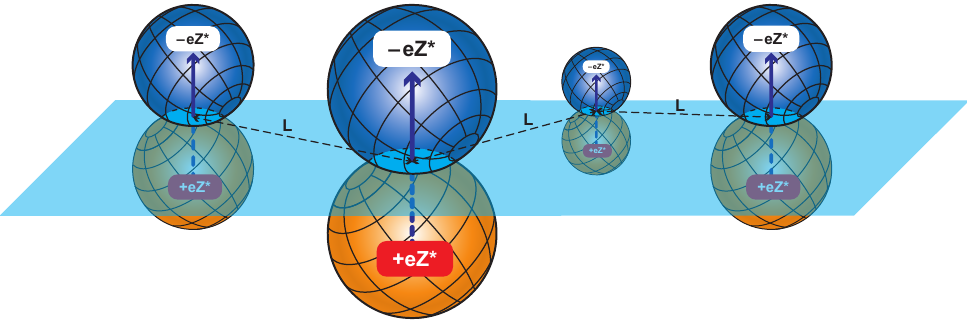
Figure 3. Interacting dipole gas in the vicinity of the interface. The counterions partially leave the coats of colloidal particles, which leads to acquisition of the effective charge eZ ∗ (cid:29) e by the latter. Formed in this way, charged complexes, together with their mirror images, set up the electric dipoles. These dipoles, possessing the moments directed perpendicularly to the interface, constitute a 2 D gas with repulsion between particles. The average distance between the dipoles is L ∼ N − 1/2 (cid:12)